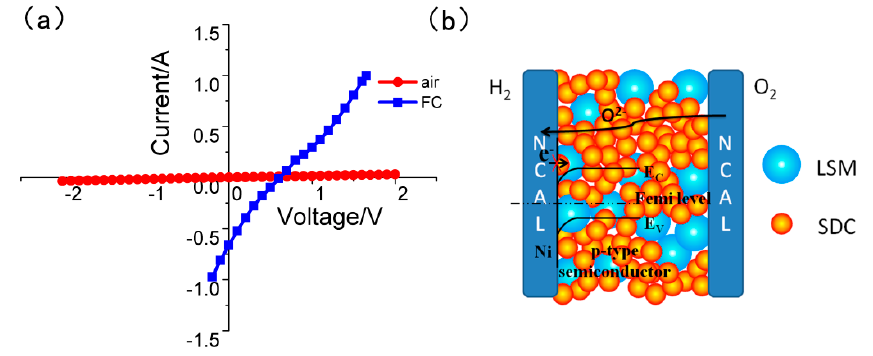
Figure 5 . ( a ) I-V curves for the SOFCs with LSM-SDC (La 0.1 Sr 0.9 MnO 3 −δ -Ce 0.8 Sm 0.2 O 2 −δ ) with weight ratio of 1:2. Scan rate: 50 mV/s; Test conditions: H 2 /air atmosphere (FC), air/air atmosphere (air), 550 o C; ( b ) Schematic of the Schottky junction in the fuel cell.